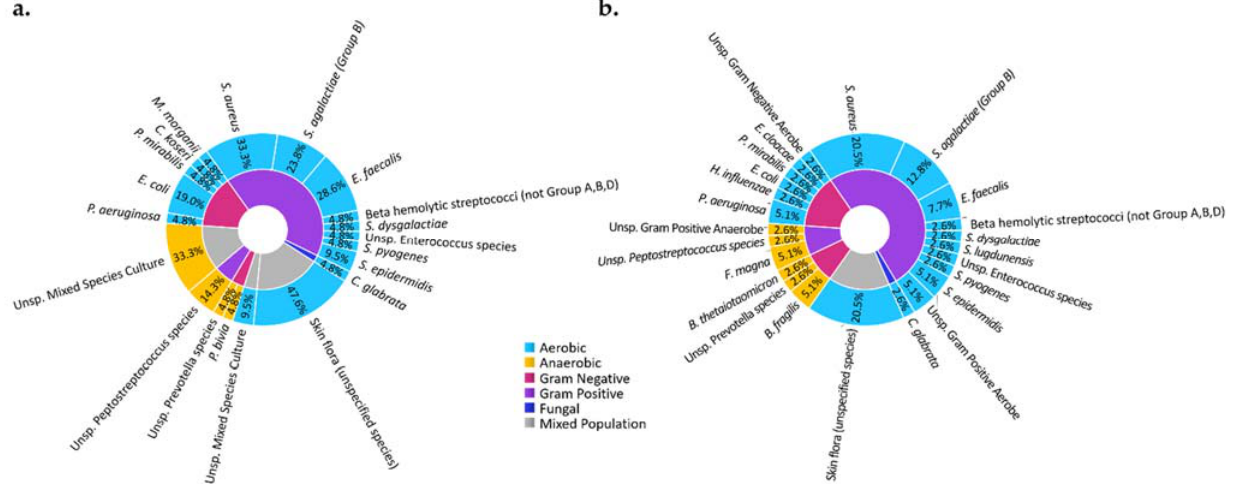
Figure 3. Microbiota of DFI of observed in subjects of an ongoing clinical study in a tertiary care facility in our medical center at the University of Texas Southwestern Medical Center. Microbiota of DFI in soft tissue biopsies ( a ) and bone biopsies ( b ) show that most microbes are aerobic (blue) and gram positive (purple), with Staphylococcus aureus being the most identified microorganism. The study was conducted according to the guidelines of the Declaration of Helsinki and approved by the Institutional Review Board (or Ethics Committee) of the University of Texas Southwestern Medical Center (IRB: 112016-043, approved November 2016). Informed consent was obtained from all subjects involved in the study.